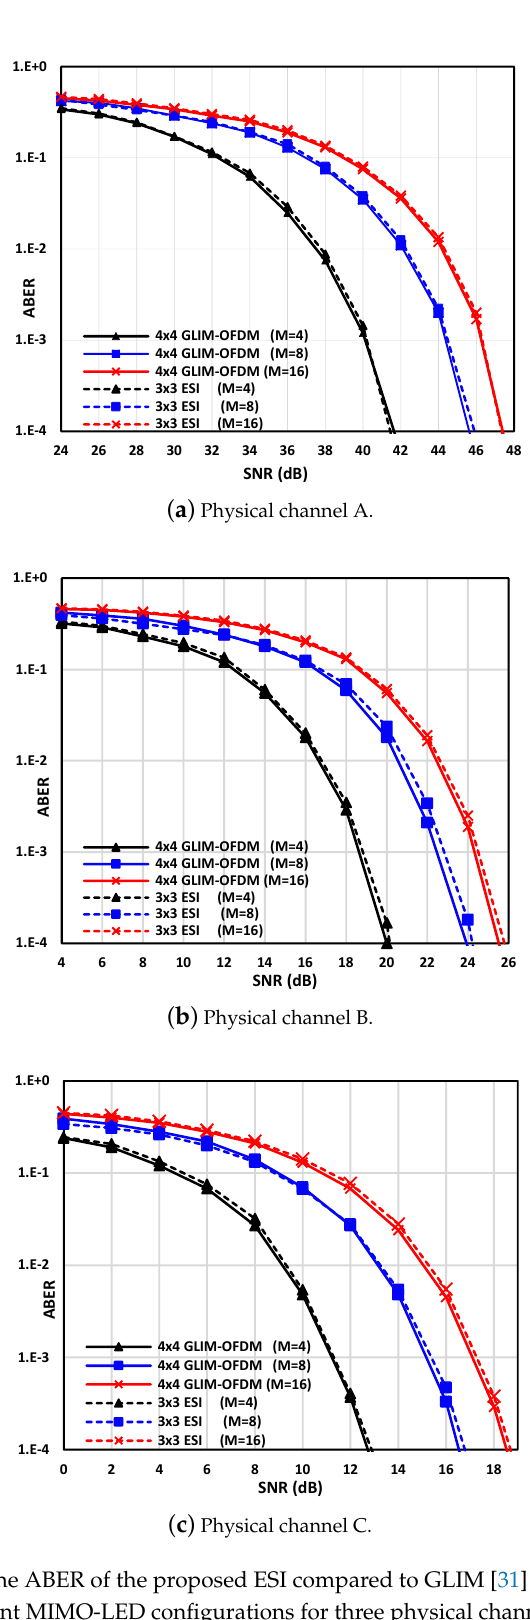
Figure 4. Scenario 1: The ABER of the proposed ESI compared to GLIM [31] at the same modulation orders, but with different MIMO-LED configurations for three physical channels, A, B, and